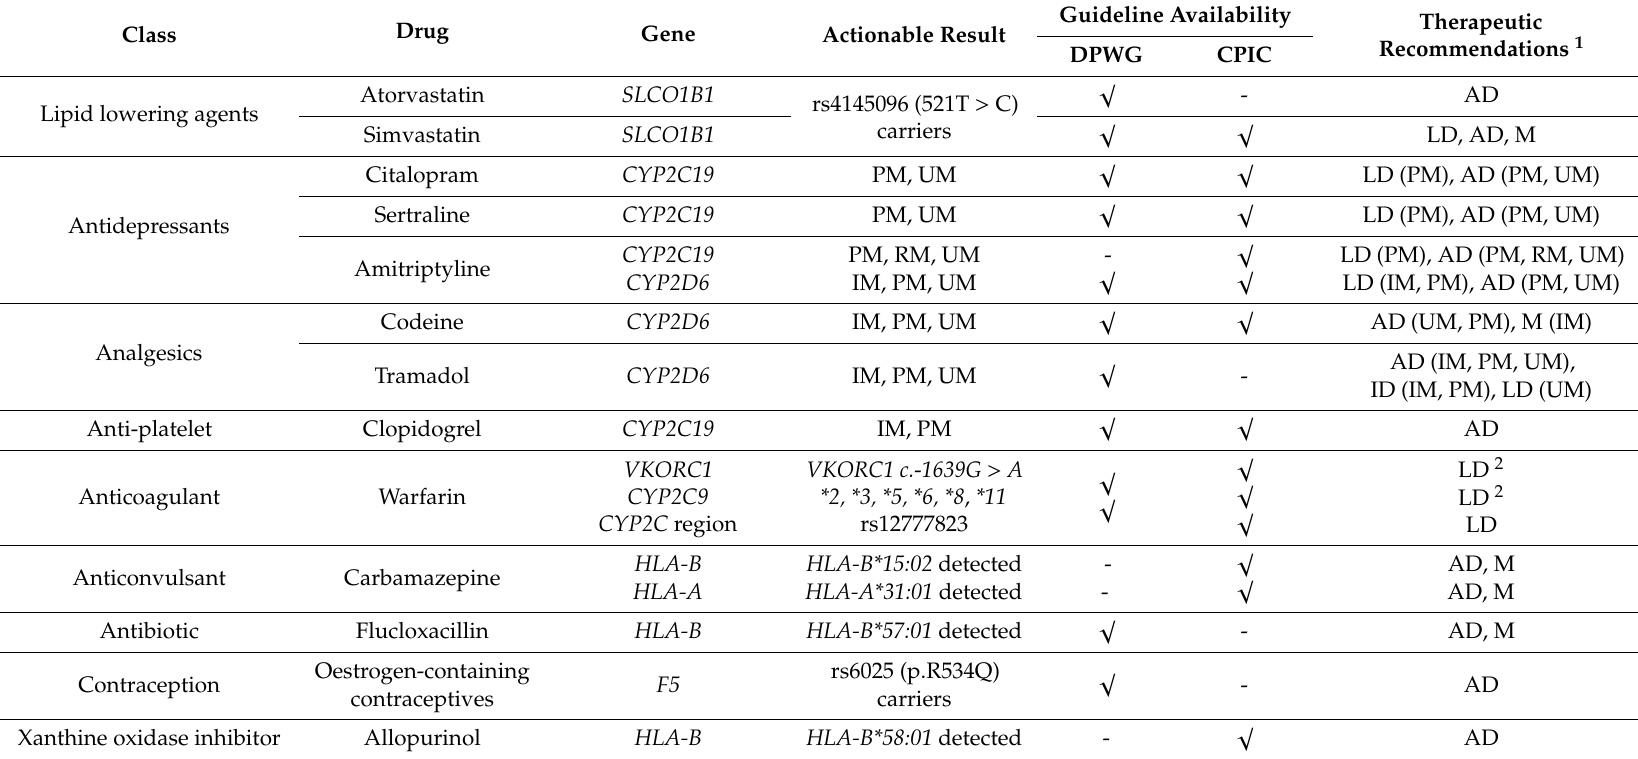
Table 1. Commonly used drugs in primary care with available pharmacogenomics